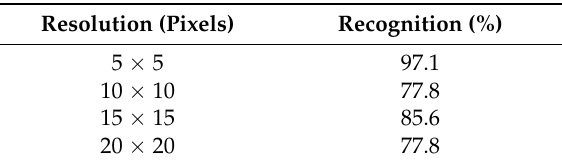
Table 1. Recognition results for the four kinds of